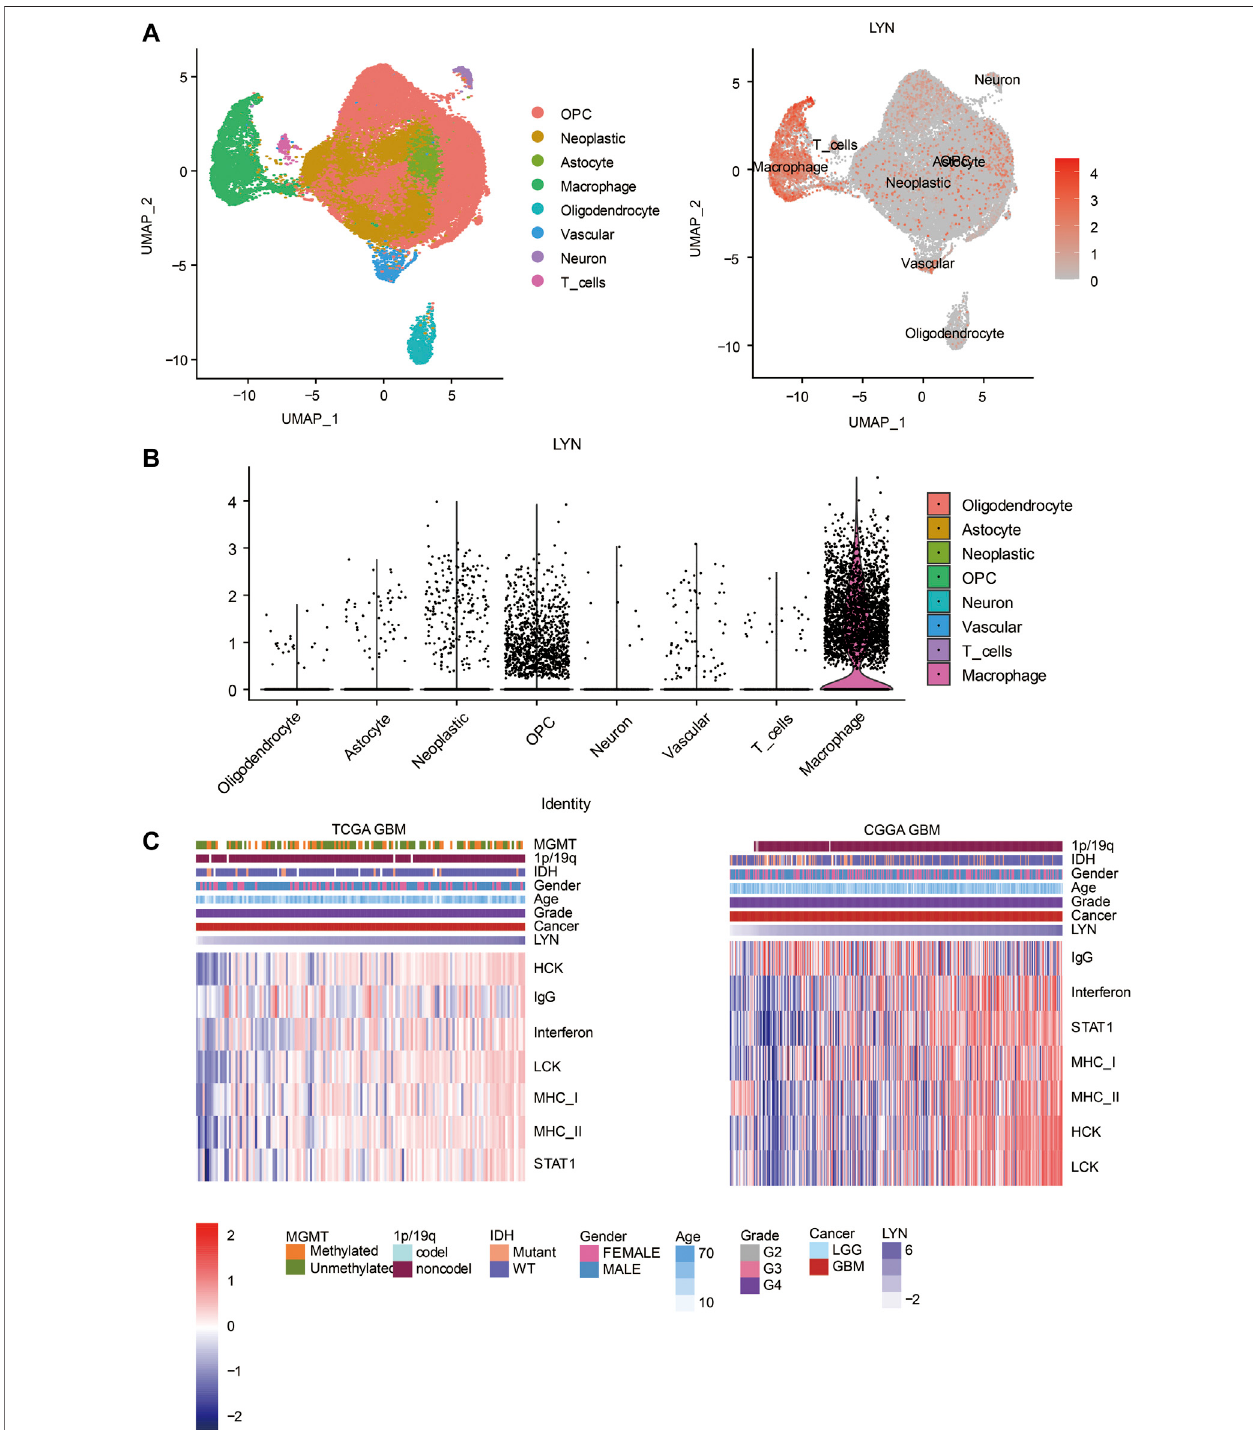
FIGURE 6 | Single cell sequencing analysis (A) . UMAP plot showing 8 cell clusters. Gray area represents all clustered cells. The red dot represents cell expressing LYN (B) . The expression level of LYN in 8 cell clusters (C) . Heatmaps illustrating LYN related in fl ammatory activities in TCGA GBM and CGGA GBM, respectively. The expression values are z-transformed. High expression values are colored red and low expression values are colored blue.